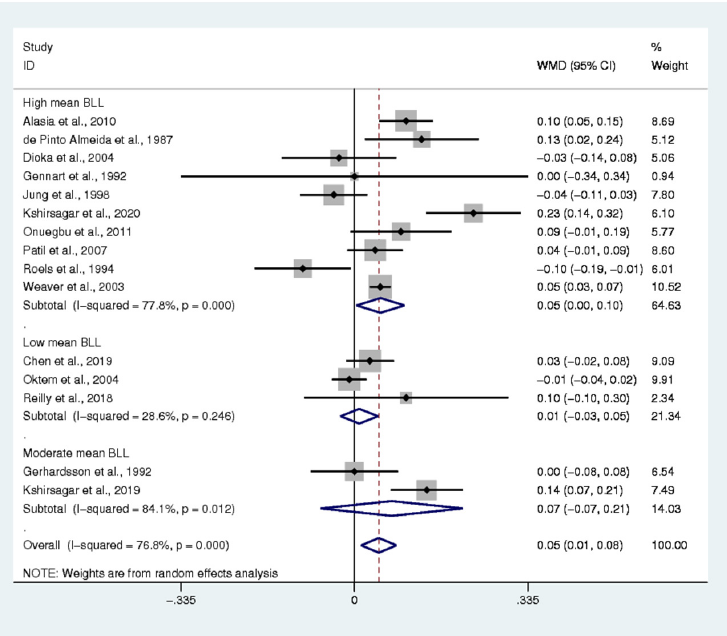
Figure 6. The mean difference in creatine levels between exposed and non - exposed participants. WMD: Weighted Mean Difference (mg/dL), % Weighted: the impact proportion of each study to the pooled effect, CI: Confidence Interval (mg/dL), Black diamond symbol: point estimate for each study, White diamond symbol: pooled WMD in each subgroup or all groups, Solid line in the middle of the graph at 0: no difference in WMD between the two groups, Dashed line: pooled WMD between two groups.